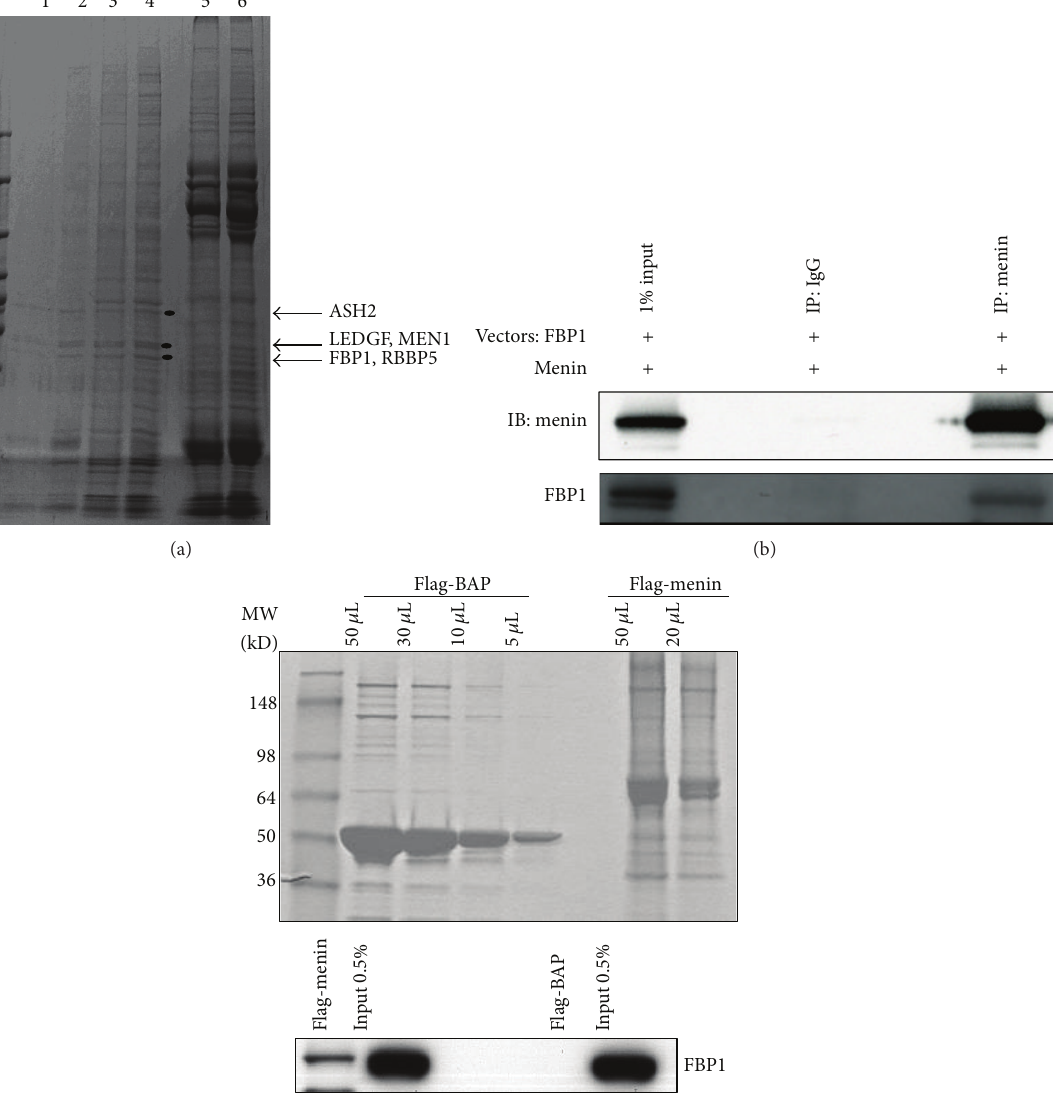
done in leukemic cell lines while we performed our exper- iments in HEK293 cells [13]. These results might reflect a cell-type specific regulation of MYC by FBP1. For example, FBP1 expression did not correlate with MYC expression in hepatocellular carcinoma tissues [18, 24]. Additionally, FBP1 might need additional factors to stimulate MYC